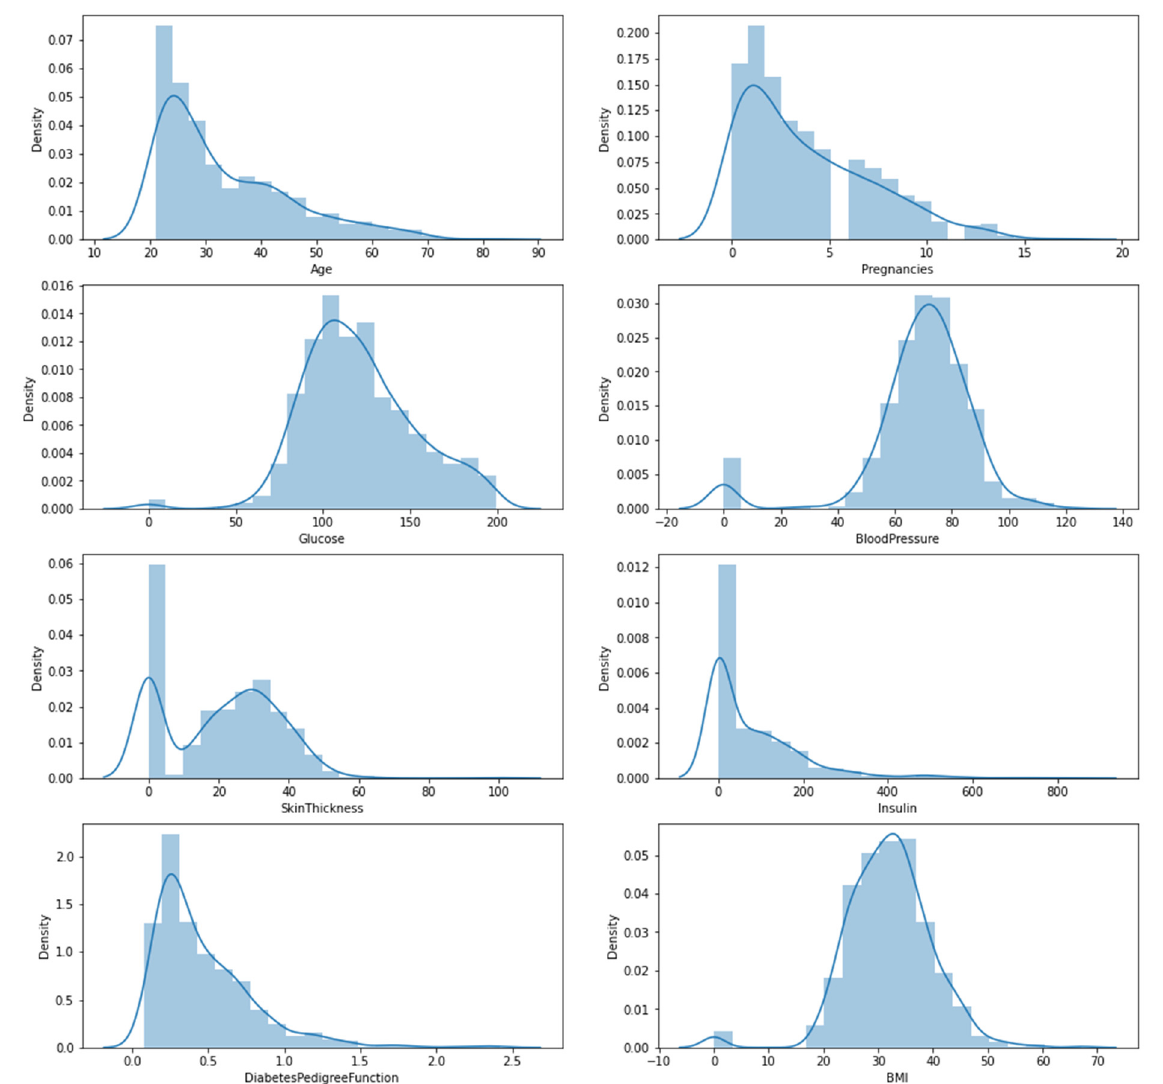
Figure 6. Histogram and density graphs of all variables.